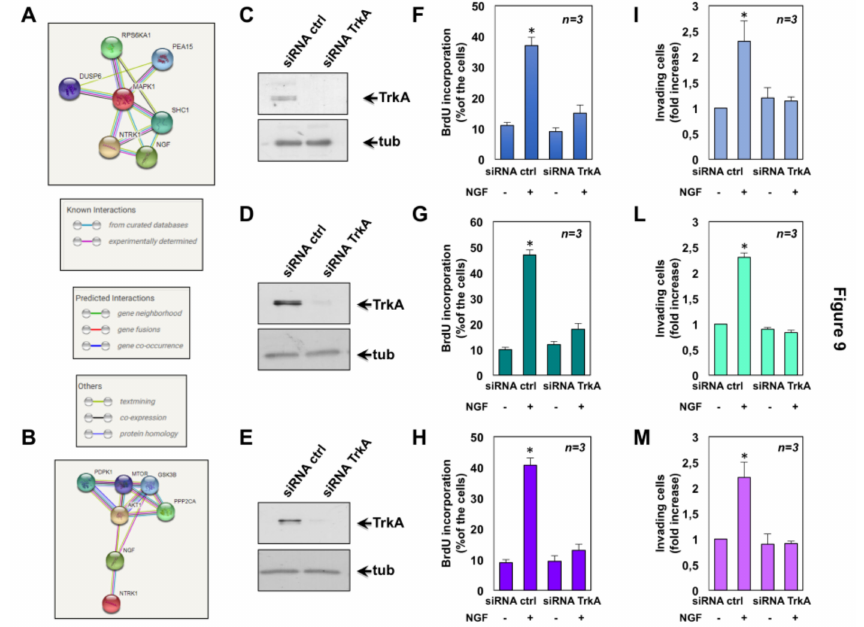
Figure 9. Results from Search Tool for the Retrieval of Interacting Genes / Proteins (STRING) network and e ff ect of Tropomyosin receptor kinase A (TrkA) knockdown in castration-resistant prostate cancer (CRPC) cells. Combined screenshots from the STRING website, which has been queried with TrkA (NTRK1) and extracellular signal-regulated kinase (ERK; MAPK1; A ) or TrkA (NTRK1; neurotrophic tyrosine kinase) and Akt (or PKB, protein kinase B, AKT1; B ) are shown. Colored lines between the proteins indicate the various type of interaction, as described in the inset in A . Protein nodes also indicate the availability of 3D protein structure information. C4-2B ( C ), DU145 ( D ) and PC3 ( E ) cells were transfected with TrkA siRNA or control siRNA, as reported in Methods. After transfection, the cells were made quiescent and then left un-stimulated or stimulated with Nerve growth factor (NGF). In C – E , protein lysates were analyzed by western blot using the antibodies against the indicated proteins. Transfected C4-2B ( F ), DU145 ( G ) and PC3 ( H ) cells on coverslips were left untreated or treated for 18h with 100ng / mL NGF. After in vivo pulse with 100 µ M BrdU, BrdU incorporation was analyzed by IF and expressed as % of total cells. Transfected C4-2B ( I ), DU145 ( L ) and PC3 ( M ) cells were used for invasion assays in Boyden’s chambers pre-coated with Matrigel. NGF (100 ng / mL) was added to the upper and the lower chambers. After 24 h, invading cells were counted as reported in Methods. In F – M , the cells were co-transfected with siRNA Alexa Fluor 488 to help identification of transfected cells. Results from three di ff erent experiments were collected and expressed as fold increase. Means and standard error of the means (SEMs) are shown. n represents the number of experiments. * p < 0.05 for the indicated experimental points vs. the corresponding untreated